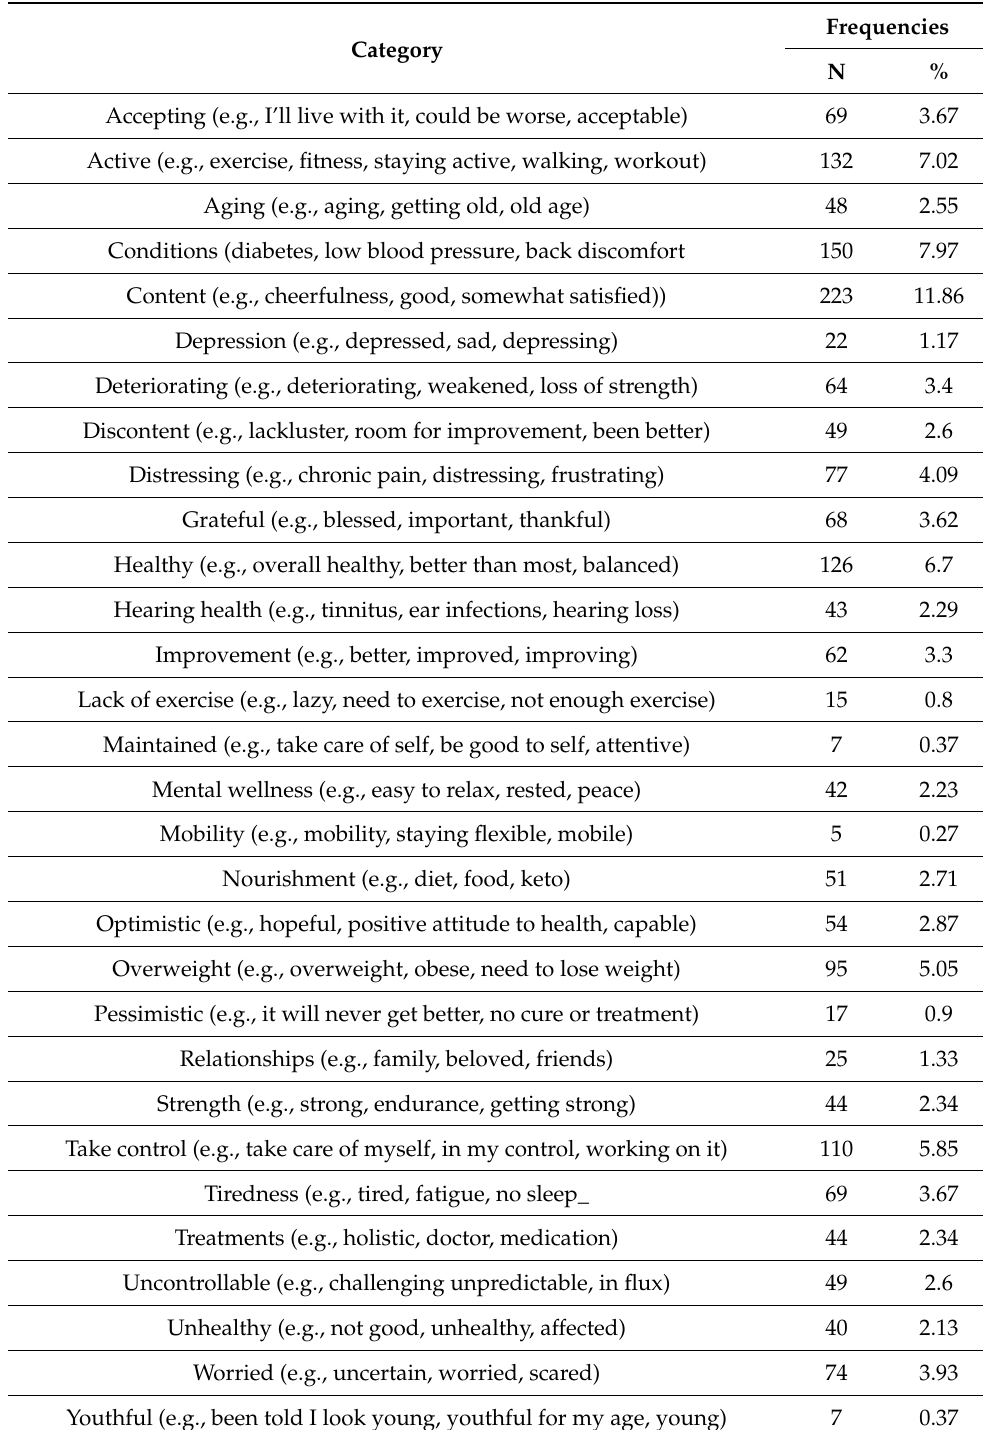
Table 3. Percentage of categories for